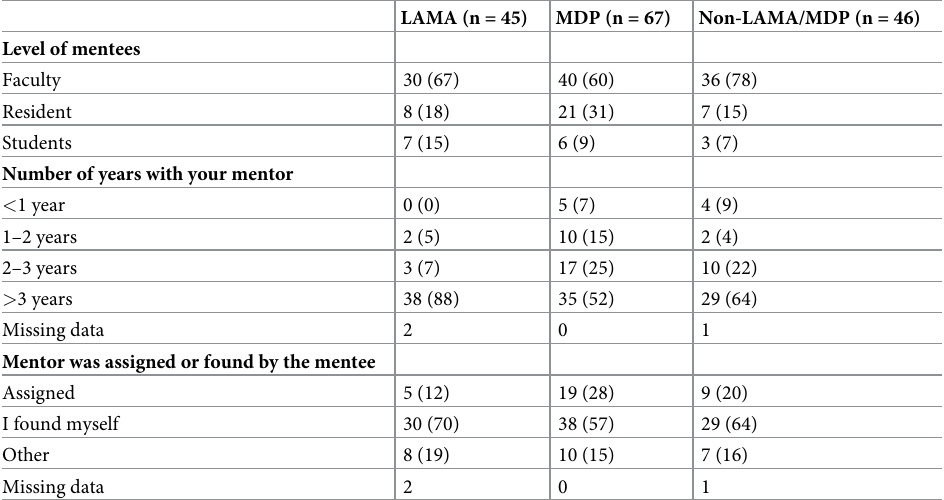
Table 2. Characteristic of the mentees (N = 158) count (Percent). LAMA (n = 45) MDP (n = 67) Non-LAMA/MDP (n = 46) Level of mentees Faculty 30 (67) 40 (60) 36 (78) Resident 8 (18) 21 (31) 7 (15) Students 7 (15) 6 (9) 3 (7) Number of years with your mentor < 1 year 0 (0) 5 (7) 4 (9) 1–2 years 2 (5) 10 (15) 2 (4) 2–3 years 3 (7) 17 (25) 10 (22) > 3 years 38 (88) 35 (52) 29 (64) Missing data 2 0 1 Mentor was assigned or found by the mentee Assigned 5 (12) 19 (28) 9 (20) I found myself 30 (70) 38 (57) 29 (64) Other 8 (19) 10 (15) 7 (16) Missing data 2 0 1 MDP = Mentors who completed the Mentor Development Program, LAMA = awardees and nominees of the Lifetime Achievement in Mentorship Award, and All Non-LAMA/MDP = Mentors who are not awardees